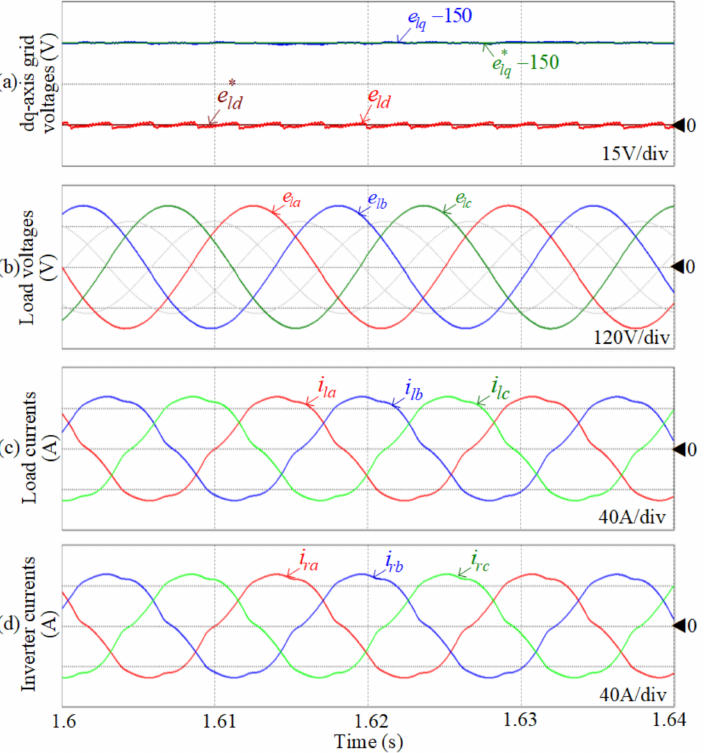
Figure 5. Control performance of the microgrid under the stand-alone modes: ( a ) dq -axis components of the load voltages; ( b ) load phase voltages; ( c ) load currents; ( d ) inverter output